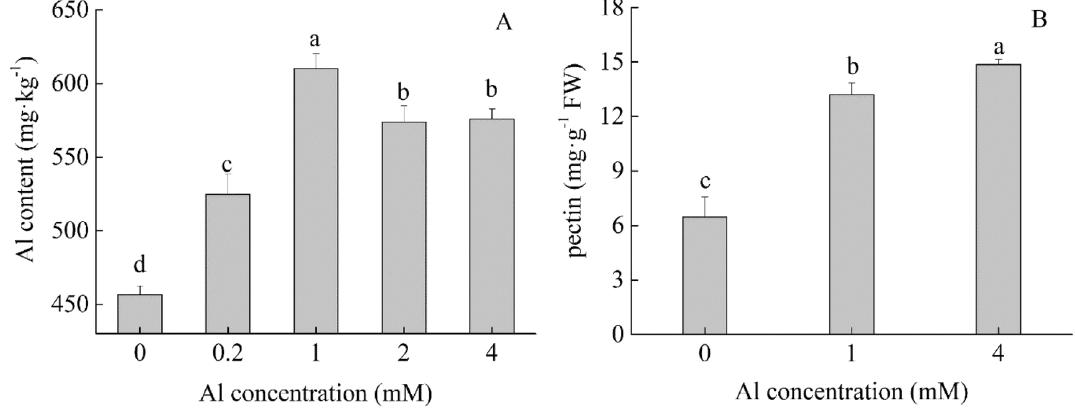
Figure 1. Changes in Al ( A ) and pectin contents ( B ) in tea plant leaves under Al treatment. Values with the same letters are not significantly different (at α = 0.05) from each other.